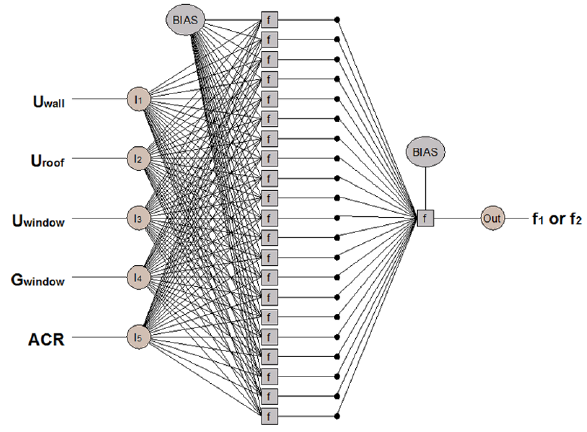
Fig. 1. Artificial neural networks